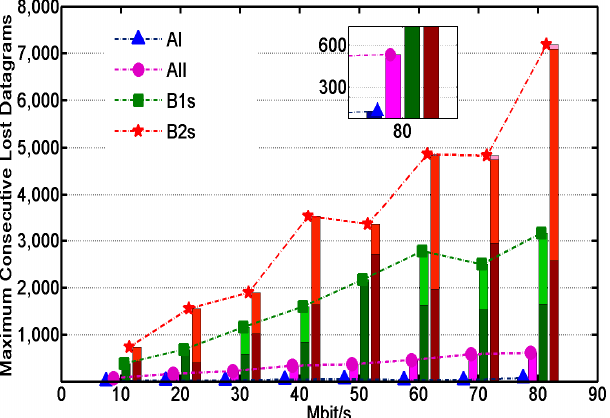
Figure 7. The number of consecutive packet losses during recovery time.